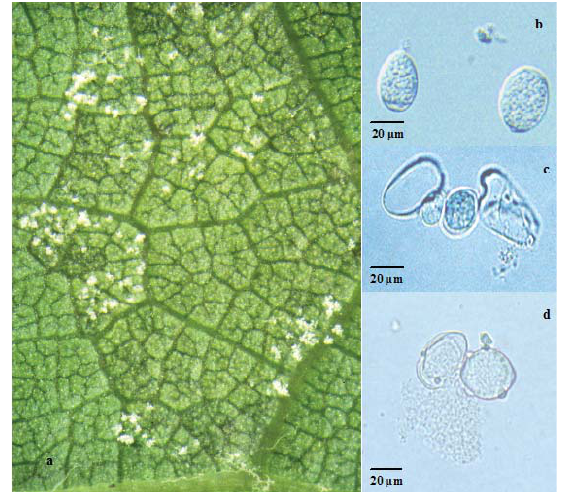
Fig. 3. (a) Rare and sporadic sporulation of P. viticola emerging 8 dpi from the edge of the inoculation point in a leaf inoculated in April. (b) P. viticola sporangia germinating in control solutions (water and DMSO), and (c) in the culture fi ltrate of A. byssoides grown in MPGB medium. (d) Degenerated sporangia treated with crude extract of A. byssoides grown in